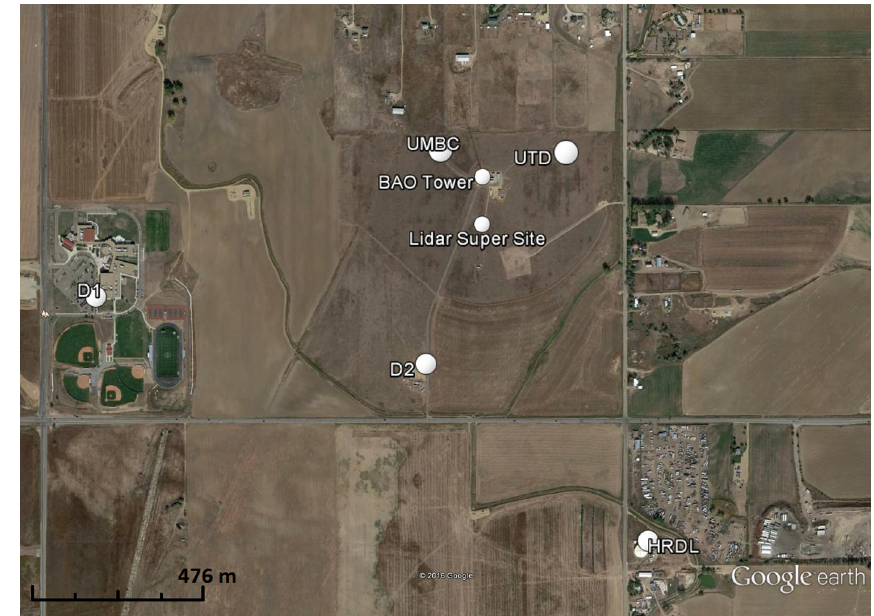
Figure 1. Scanning Doppler lidar deployment location during the XPIA field